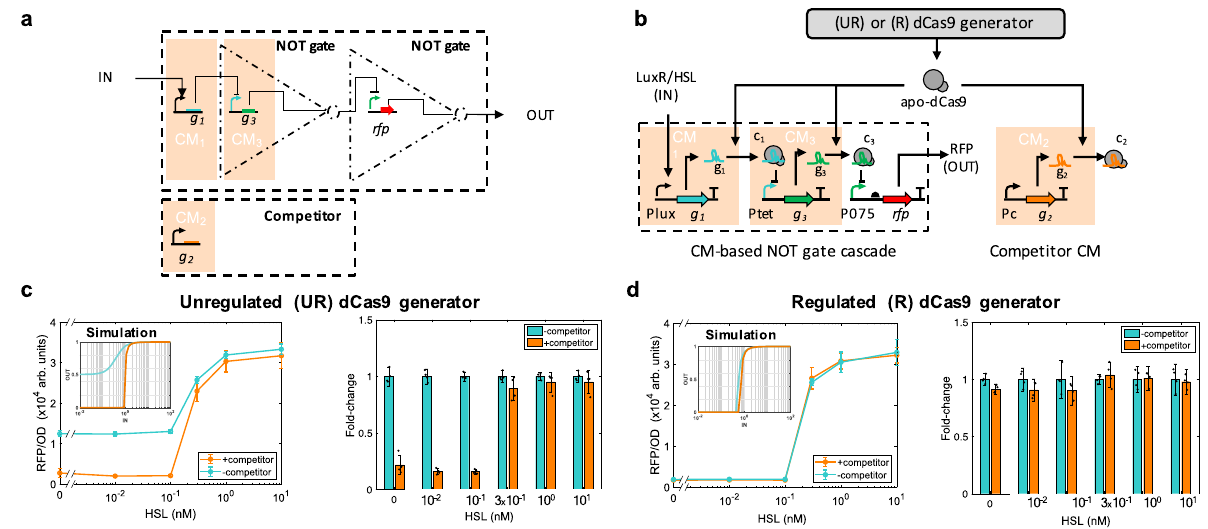
Fig. 3 Effect of competitor CM on layered CM-based circuit with UR and R dCas9 generators. a Logic diagram of a two-stage NOT gate cascade. Each NOT gate comprises repression of a constitutive promoter by an sgRNA. b Genetic circuit diagram of CM-based NOT gate cascade with either UR or R dCas9 generators. The cascade comprises CM 1 expressing sgRNA g 1 , taking LuxR/HSL as input, and giving repressive complex c 1 as an output. Repressor c 1 then represses expression of sgRNA g 3 in CM 3 , whose output c 3 represses RFP. The CMs are all on the same high copy number plasmid pSC101E93G (giving ~84 copies, Supplementary Note 6). The unregulated (UR) and regulated (R) dCas9 generators are as in Fig. 1a, b, respectively. Details about parts and plasmids are reported in Supplementary Note 6. c Effect of competitor CM on cascade ’ s I/O response with UR dCas9 generator. Turquoise line represents cascade ’ s I/O response in the absence of the competitor, while orange line represents I/O response in which the expression of competitor sgRNA is driven by a strong promoter (P108), (see Supplementary Note 6 and Supplementary Table 13). Inset shows steady state I/O responses obtained by simulating the ODEs listed in Supplementary Eqs. (36 – 38) with parameters given in Supplementary Table 3 where IN and OUT have the same units used in the data plots. Data in the line plots represent mean values ± SD of n = 3 or 4 biologically independent experiments. Fold changes are normalized to the no competitor data. Bar graphs with error bars and overlaid dot plots are computed according to Eqs. (1 – 3) in “ Methods ” section. d Effect of competitor CM on cascade ’ s I/O response with R dCas9 generator. Color-coding of lines is as in c . Inset shows steady state I/O responses obtained by simulating the ODEs listed in Supplementary Eqs. (39 – 41) with parameters given in Supplementary Table 3. Insets ’ IN and OUT have the same units as in the data plots. Error bars are computed as in c . Source data are provided with this